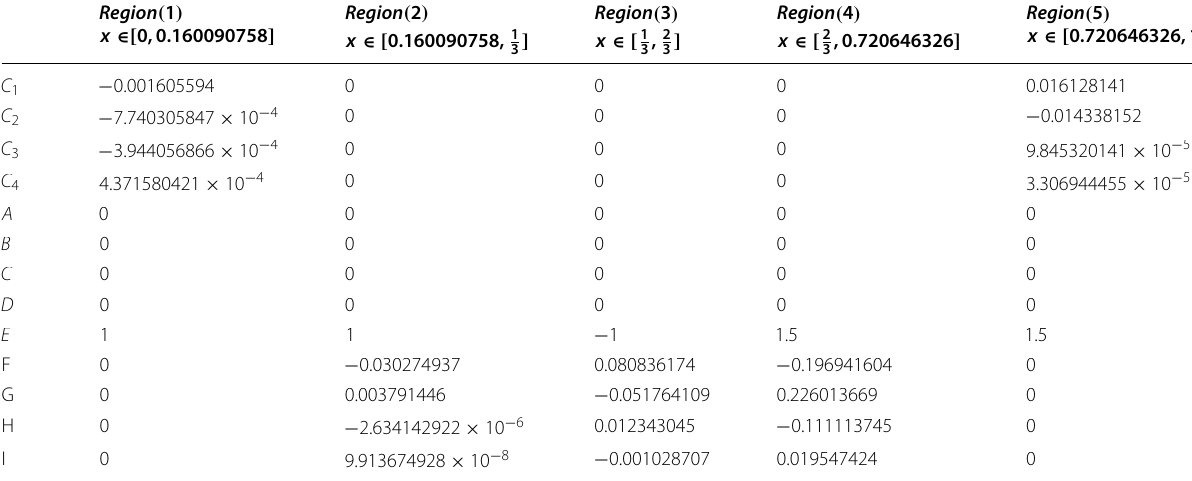
Table 7 Integration constants for exact solutions of cases